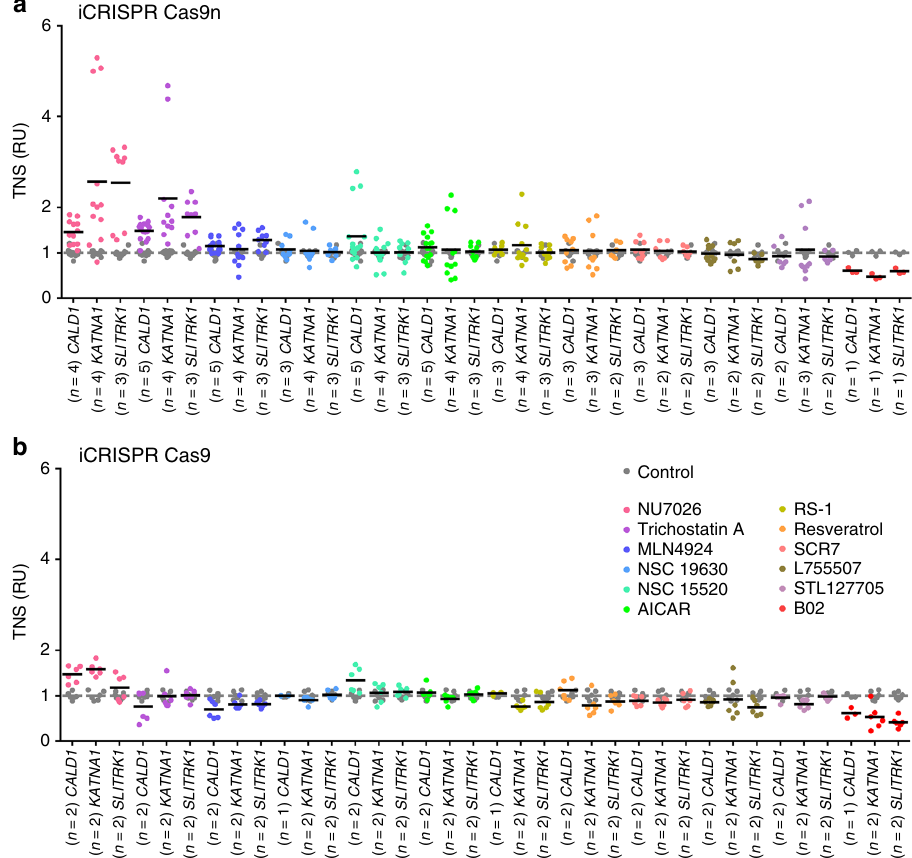
Fig. 2 Effects of small molecules on targeted nucleotide substitution (TNS) ef fi ciency in iCRISPR hiPSCs. Shown are TNS ef fi ciencies in CALD1 , KATNA1 and SLITRK1 with Cas9n ( a ) and Cas9 ( b ) in 409-B2 iCRISPR hiPSCs. TNS ef fi ciency is given in relative units (RU) with the mean of controls set to 1 to account for varying ef fi ciency in different loci. Shown are technical replicates of n independent experiments. Data from Fig. 3 and Supplementary Fig. 3 are included. Gray and black bars represent the mean of the control and the respective small molecule, respectively. Concentrations used were 20 µ M NU7026, 0.01 µ M Trichostatin A, 0.5 µ M MLN4924, 1 µ M NSC 19630, 5 µ M NSC 15520, 20 µ M AICAR, 1 µ M RS-1, 1 µ M Resveratrol, 1 µ M SCR7, 5 µ M L755507, 5 µ M STL127685, and 20 µ M B02. Mean absolute percentages of TNS and indels of all technical replicates are shown in Supplementary Table